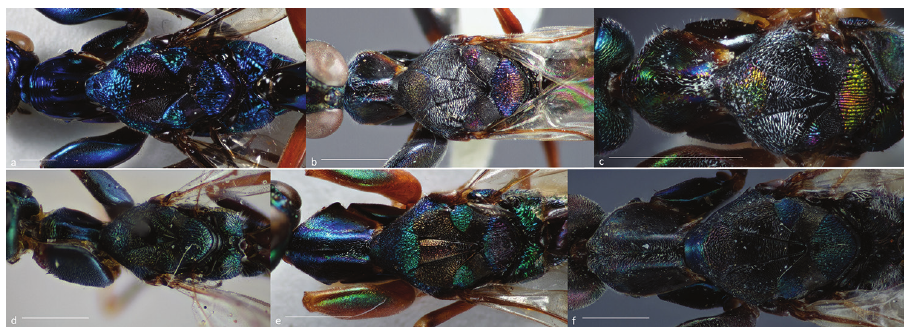
Figure 12. Mesosoma (dorsal) II a O. gracilis Westwood (imaged specimen: OGr01) b O. heikewernerae sp. n. (OHe01, holotype) c O. hoggarensis Hedqvist (OHo02, paratype) d O. leibnizi sp. n. (OLe01, holo- type) e O. longicollis (Cameron) (OLo01) f O. madegassa Bouček (OMad01, holotype). Scale bars: 1